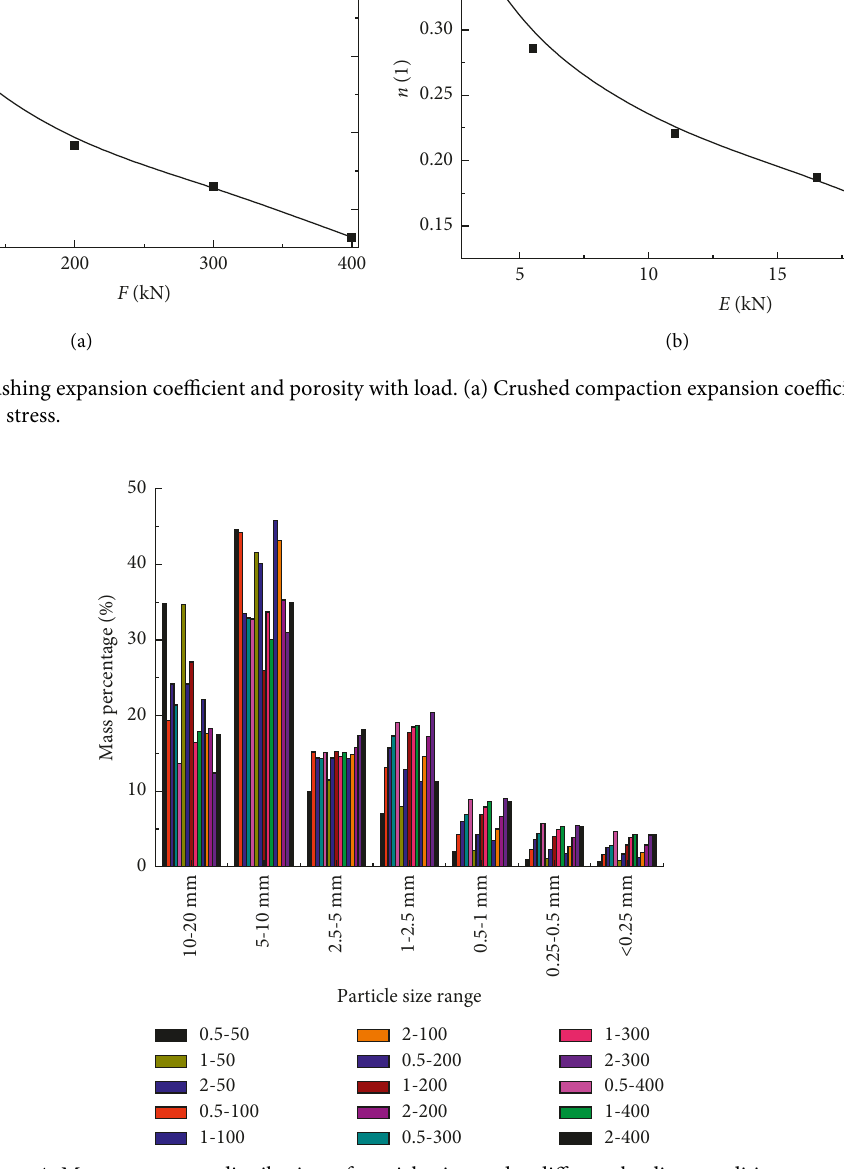
Figure 4: Mass percentage distribution of particle size under different loading